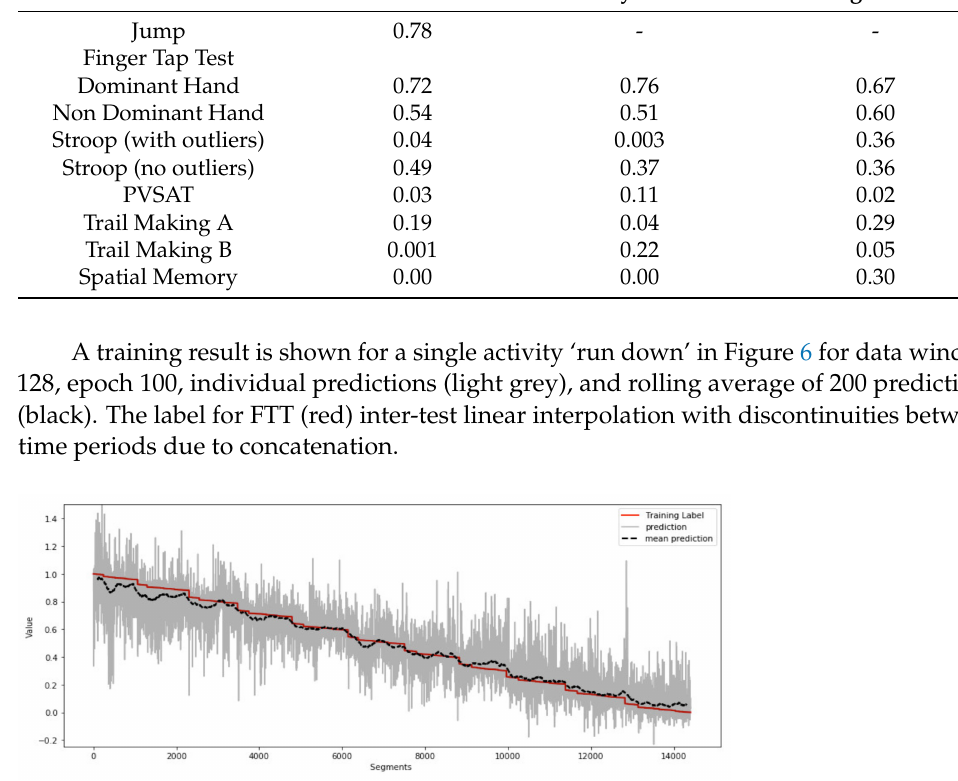
Figure 6. Training Results (BLACK) for CNN with activity ‘run down’ with training label (RED) and individual predictions